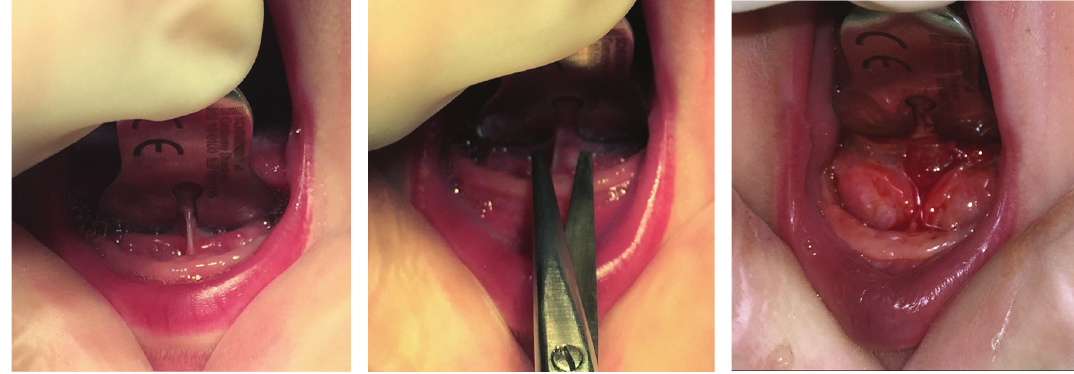
Figure 2: Lingual frenotomy, surgical technique.